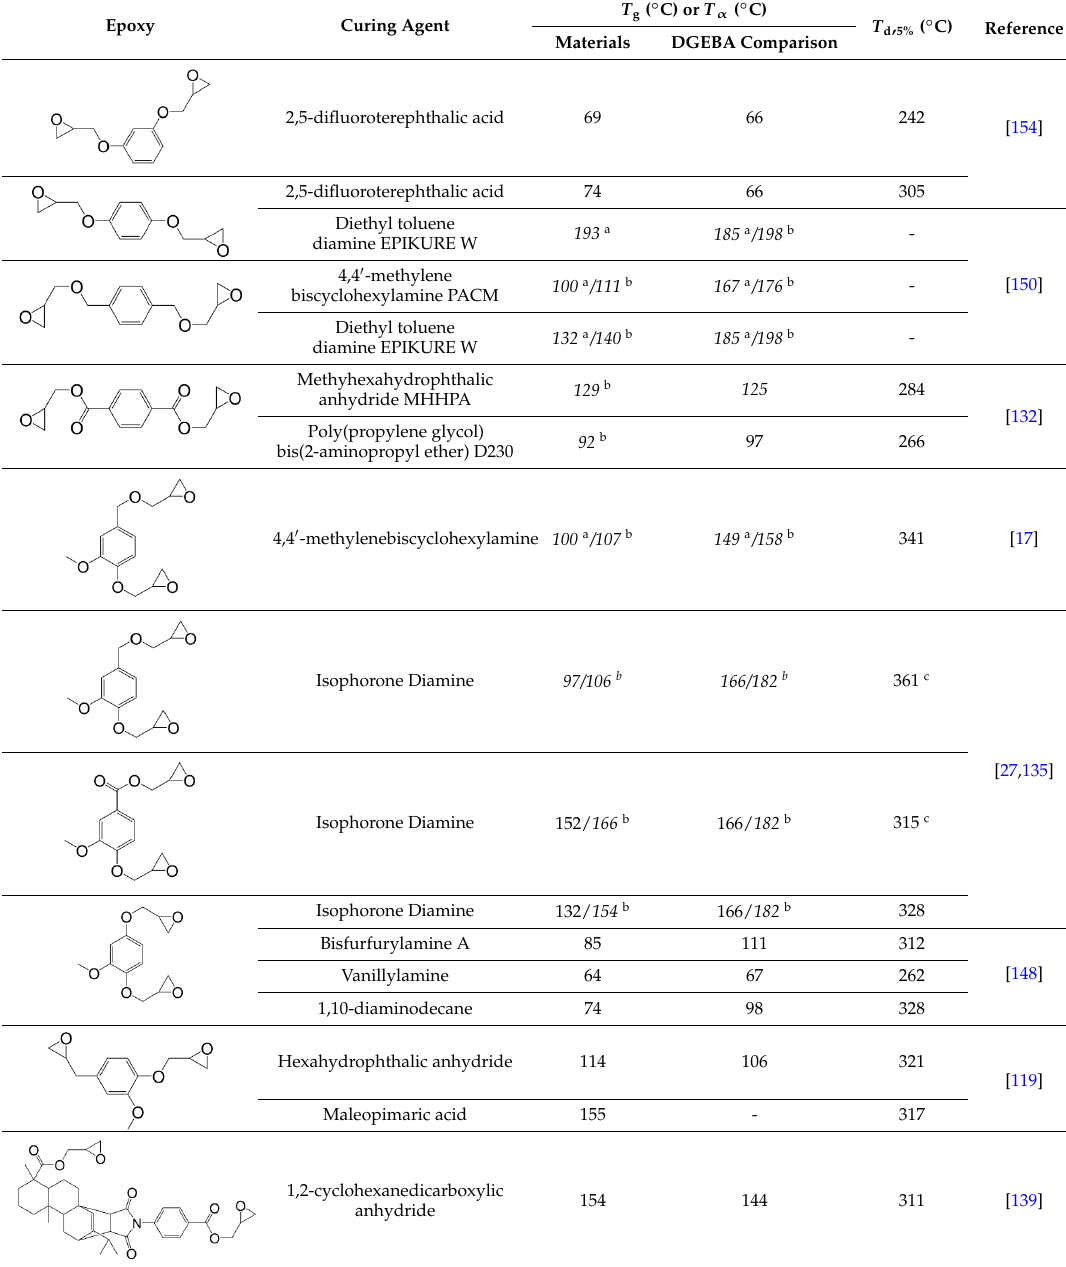
Table 2. Mono-aromatic, poly-epoxy resins and thermal properties of the cured materials. T g values are indicated in plain text, T α are in